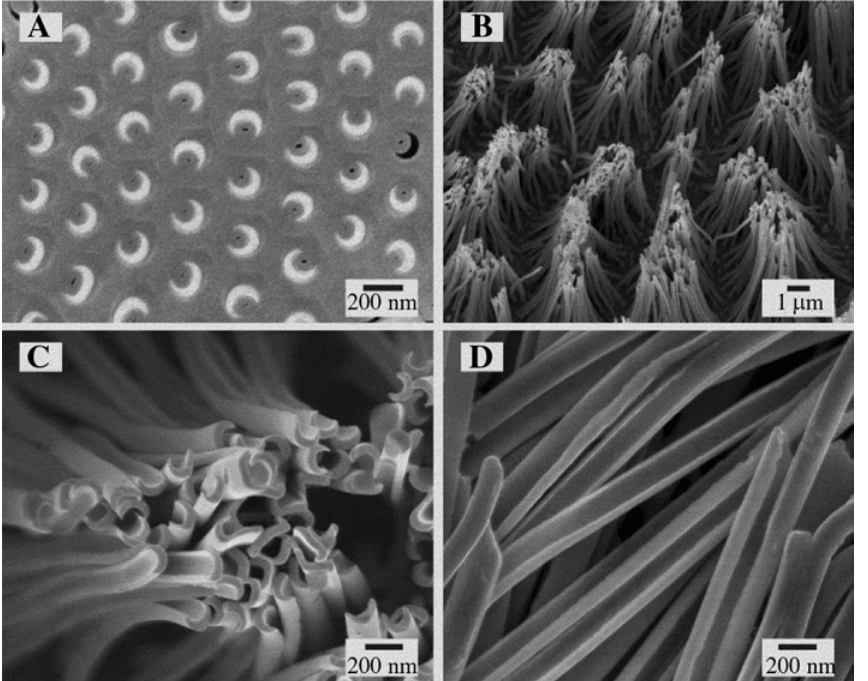
Figure 9: (A) Cross-sectional SEM image of an AAO template after electrodeposition of Au into the crescent-shaped nanochannels created with ZnO sacrificial layer. (B, C) Top-view SEM images of the HNT arrays released by dissolving the template. (D) A close-up of the HNTs. Reprinted with permission from Ref. [56]. Copyright 2011 American Chemical